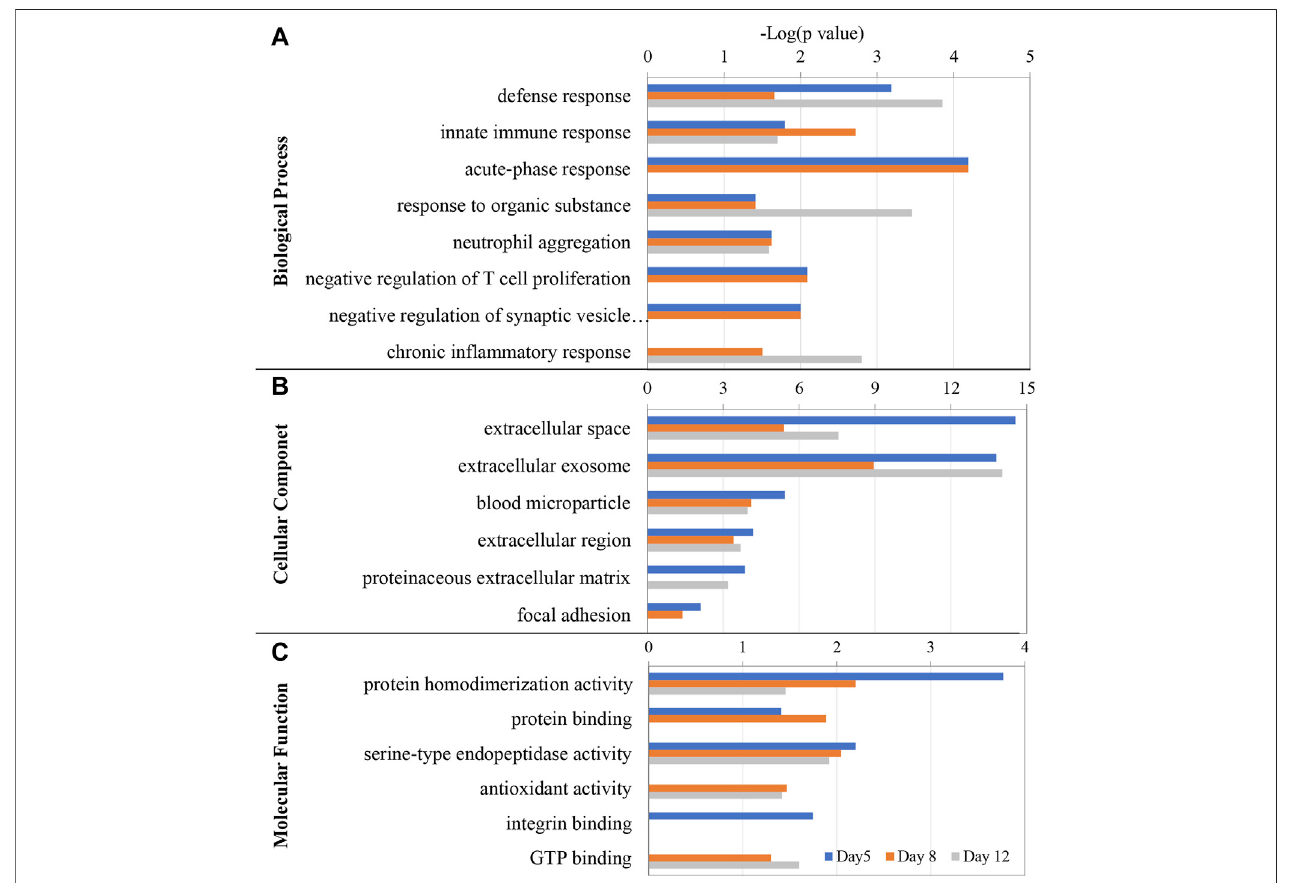
FIGURE 4 | GO enrichment analysis of the differential proteins at days 5, 8, and 12 in EAU rats. (A) Biological process; (B) Cellular component; (C) Molecular function.